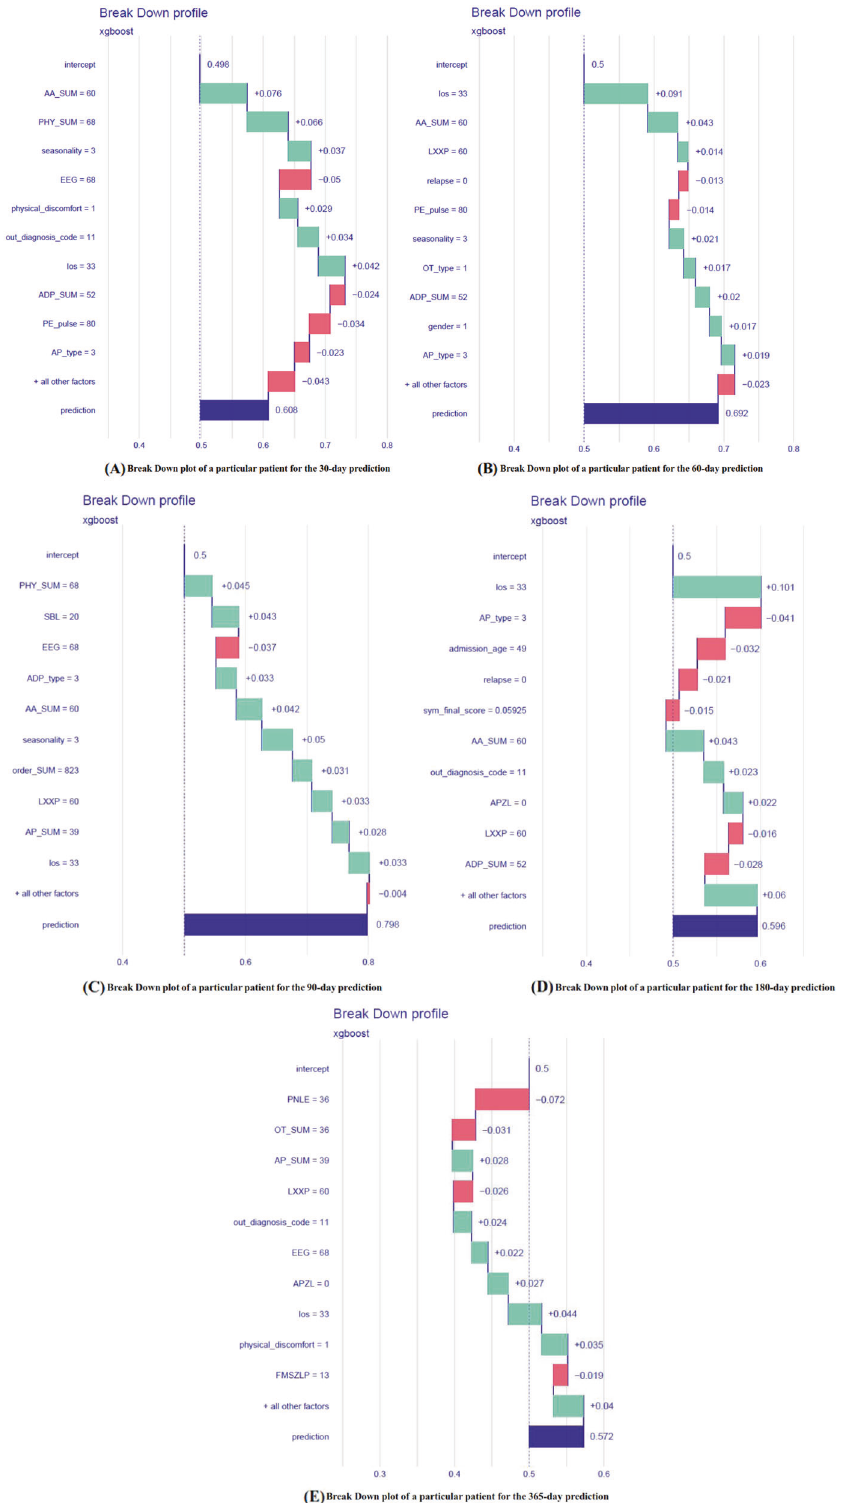
Fig. 7 Impact of input features on 30-, 60-, 90-, 180-, and 365-day psychiatric readmission prediction for a single patient. A Break Down plot of a particular patient for the 30-day prediction. B Break Down plot of a particular patient for the 60-day prediction. C Break Down plot of a particular patient for the 90-day prediction. D Break Down plot of a particular patient for the 180-day prediction. E Break Down plot of a particular patient for the 365-day